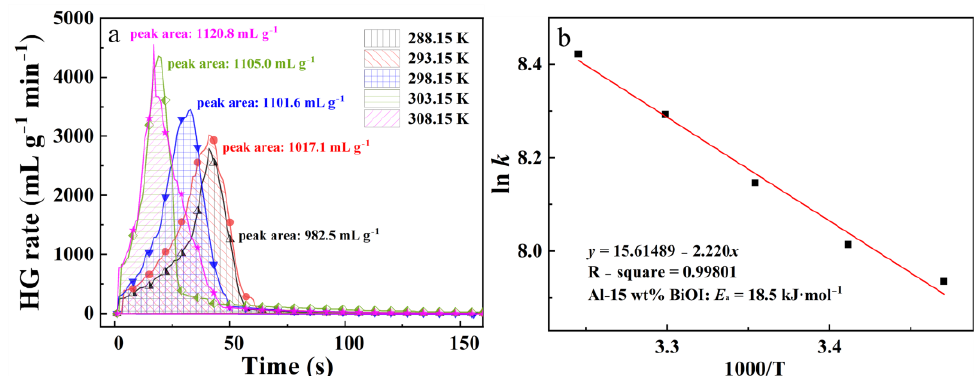
Figure 4. Curves of hydrogen generation rate ( a ) and a plot of ln k vs. 1000/T ( b ) of